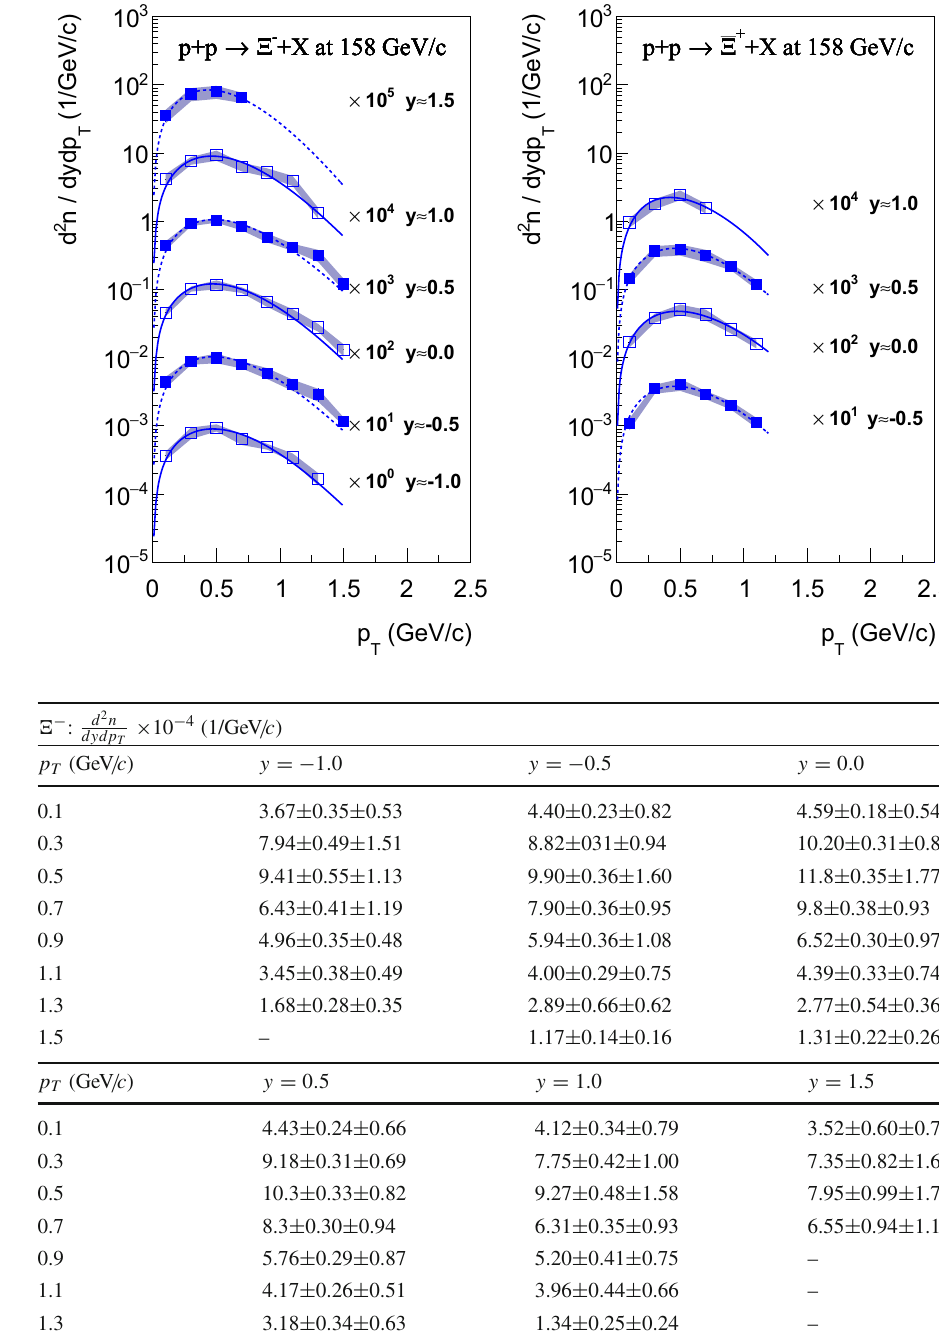
Fig. 4 Transverse momentum spectra in rapidity slices of (cid:2) − ( left ) and (cid:2) + ( right ) produced in inelastic p+p interactions at 158 GeV / c . Rapidity values given in the legends correspond to the middle of the corresponding interval. Statistical uncertainties are smaller than the marker size, shaded bands show systematic uncertainties. Spectra are scaled by the given factors for better separation